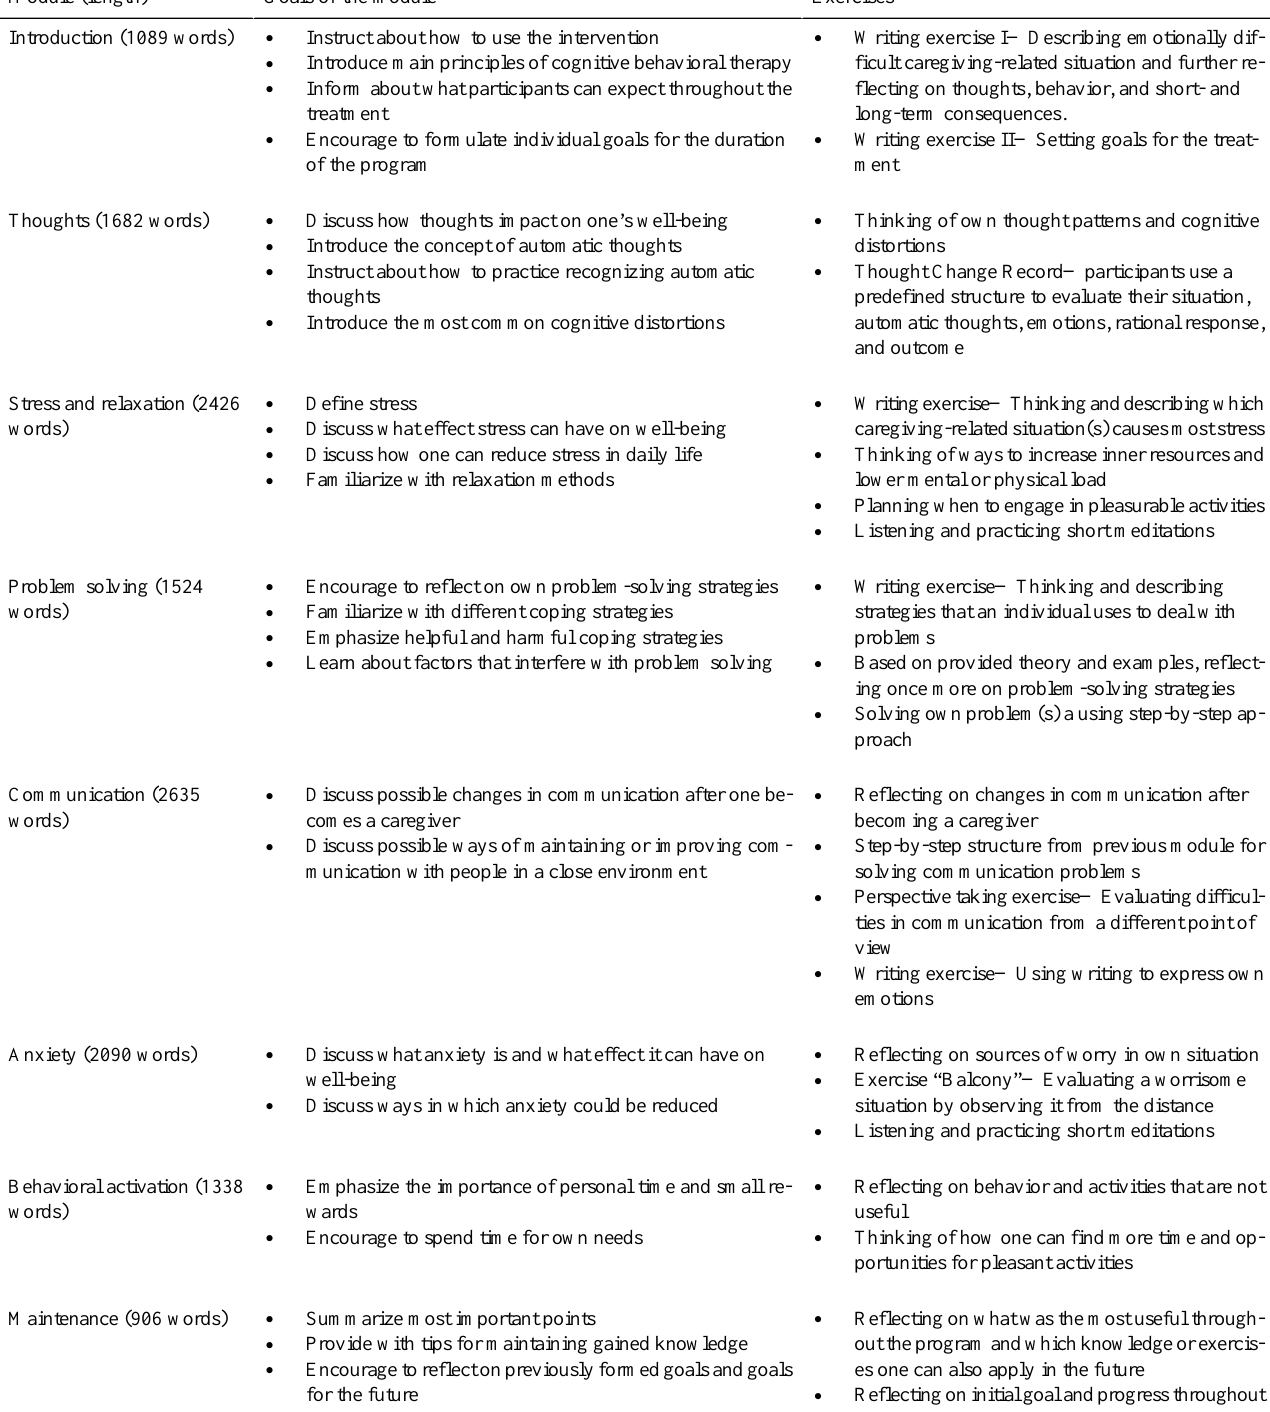
ExercisesGoals of the moduleModule